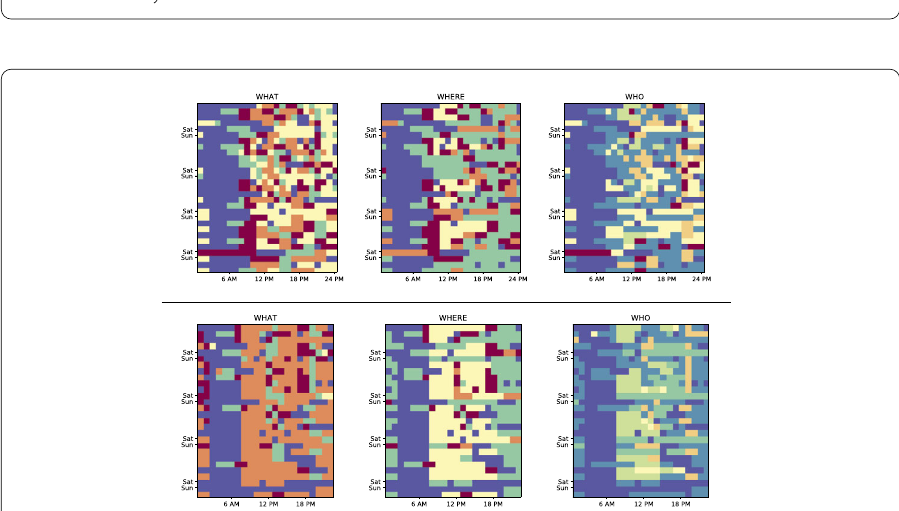
Figure 3 Annotations of an irregular (top) and a regular (bottom) study participant. For each participant, left to right: annotations for What, Where, and Who. Each row is a day, columns are hours. Colors indicate different values. The values were grouped by similarity, for interpretability. Missing values are in blue. Weekends are indicated on the y